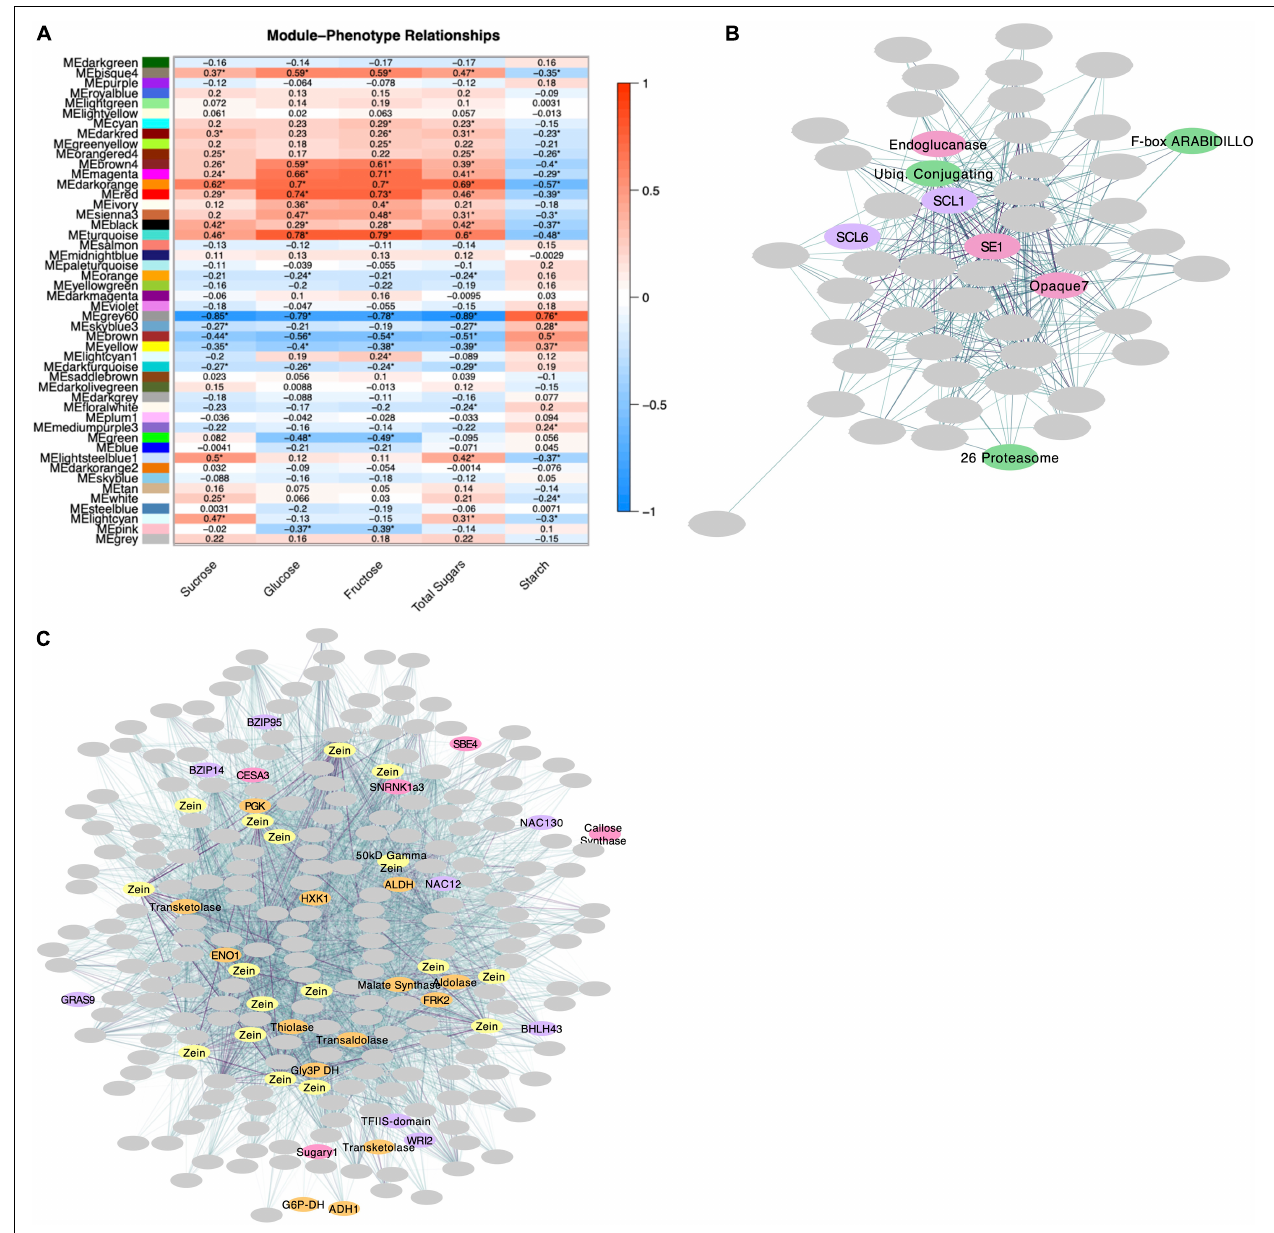
FIGURE 5 | WGCNA results. (A) Pairwise correlations between module eigengenes and phenotypic values. Significance ( P -value < 0.05) is indicated with an asterisk. (B) Visual representation of Module Lightsteelblue1 using the yFiles organic layout format. SCF-complex genes are indicated in green, genes that impact grain filling and starch metabolism are indicated in pink, and transcription factors in purple. Connection weight is indicated by line color, where darker lines represent higher-weighted connections. (C) Module Grey60 represented by Cytoscape Network Analyzer using the yFiles organic layout format. Genes encoding zein proteins are indicated in yellow, genes involved in carbohydrate metabolism are indicated in pink, transcription factors in purple and glycolytic genes in orange. Connection weight is indicated by line color, where darker lines represent higher-weighted